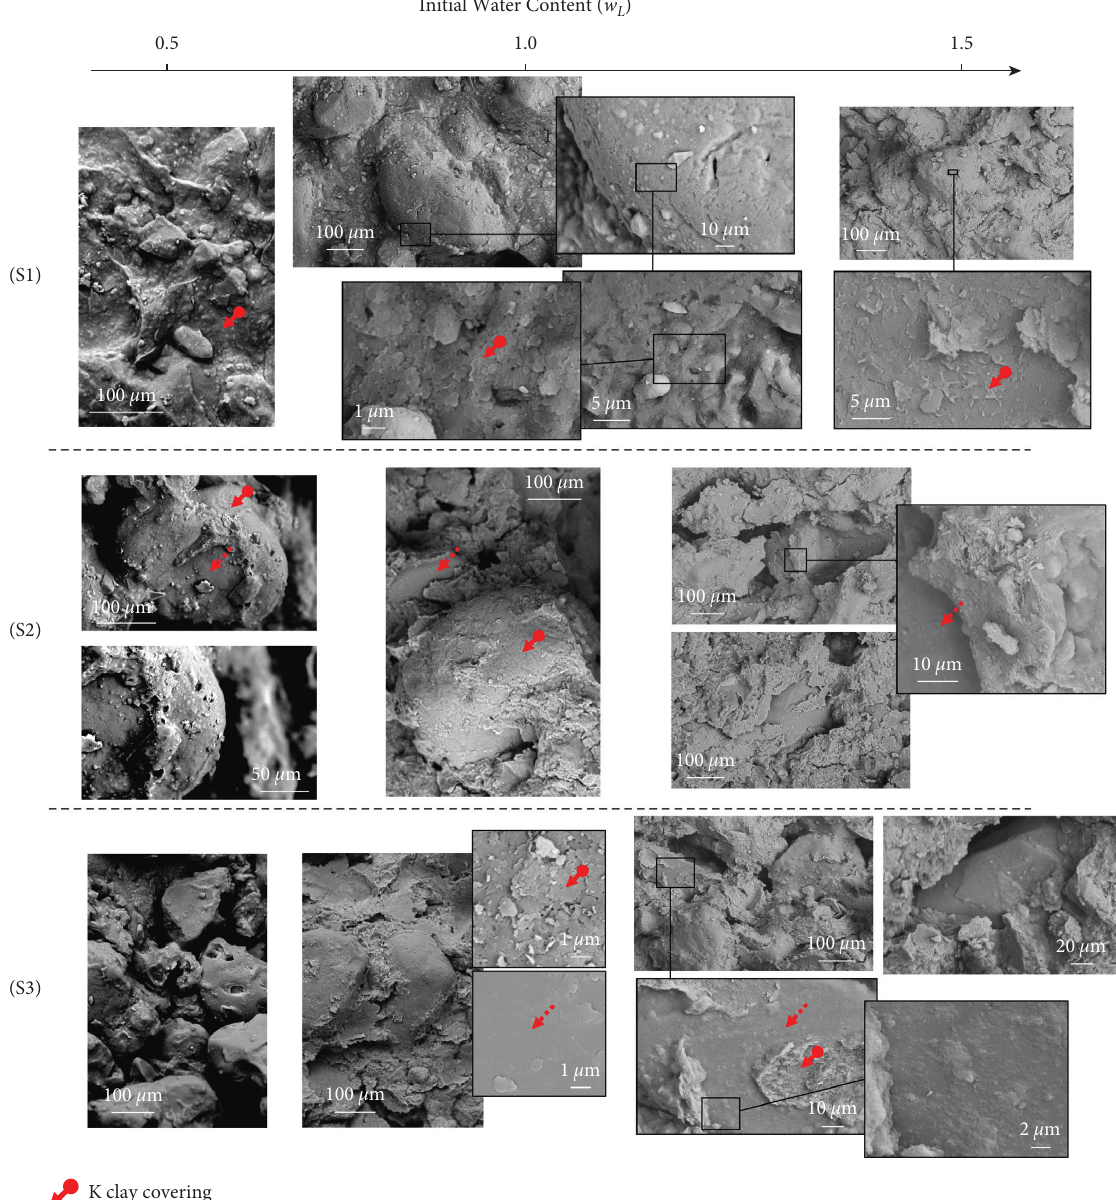
Figure 5: SEM images in secondary electron imaging mode of samples prepared by the three protocols in dry conditions and mixed at different initial water